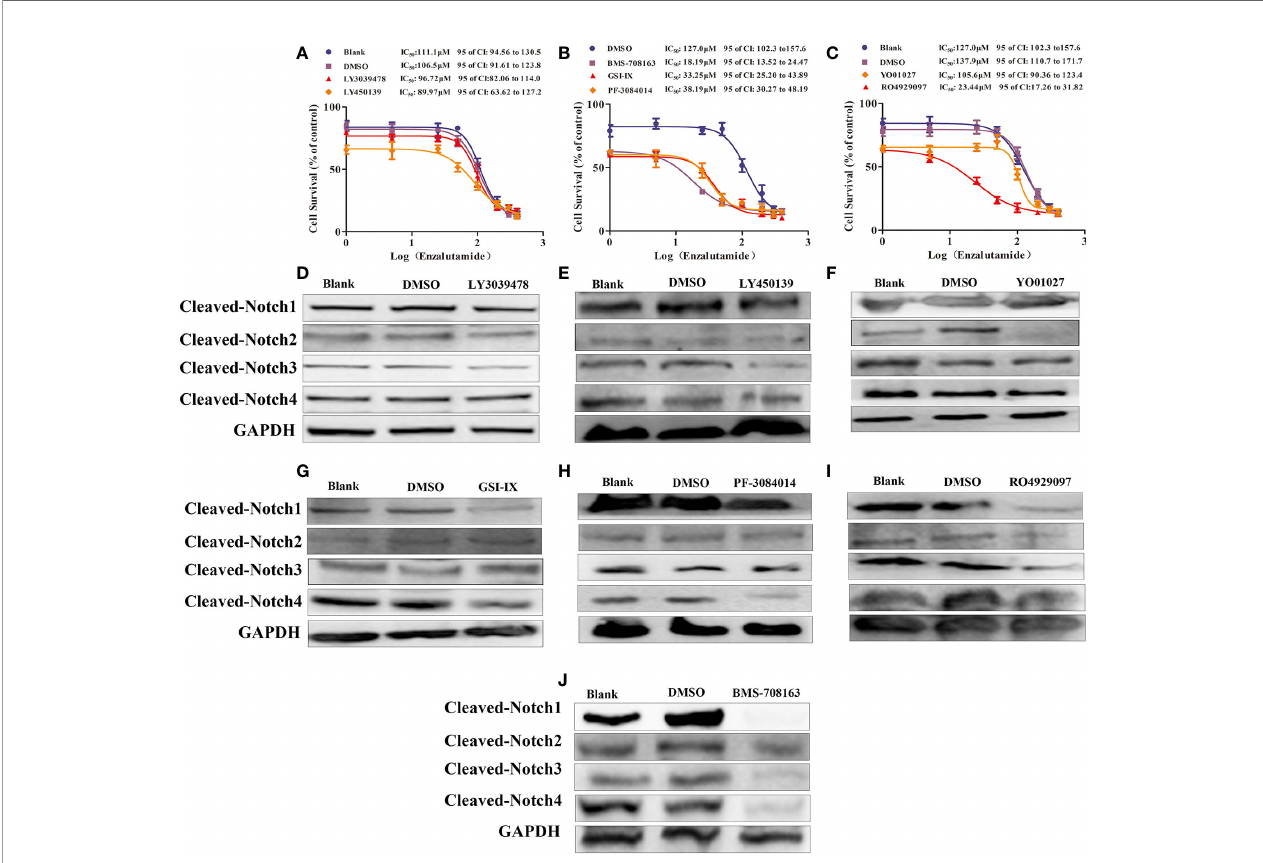
FIGURE 6 | g -secretase inhibitors reversed the resistance by decreasing activities of Notch receptors. (A – C) The half maximal inhibitory concentration (IC50) was determined by CCK-8 assay after the Enza-R cells were treated with enzalutamide and g -secretase inhibitors, LY3039478, BMS-708163, LY-450139, GSI-IX, PF- 3084014, RO4929097, LY01027 respectively for 24 h. (D – J) Activities of each Notch receptor member were determined in Enza-R cells after treated them with various g -secretase inhibitors respectively. The cleaved Notch 1 – 4 means the intracellular domain part of Notch receptor members spliced by g -secretase, which realizes the function of notch receptor members. GAPDH served as a loading control.